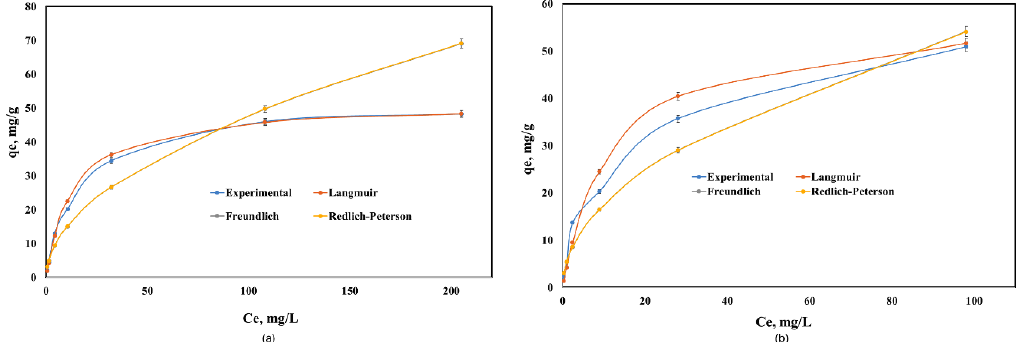
Figure 4. Kinetics of Cd(II) adsorption onto: a) Co–Gly and b) Ni-Gly. Table 2. Kinetic and statistic parameters for the kinetic models. Adsorbent